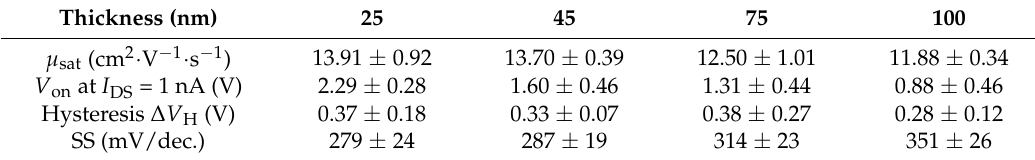
Table 3. The statistical deviation of the electrical properties of a-IGZO TFTs with various T IGZO .